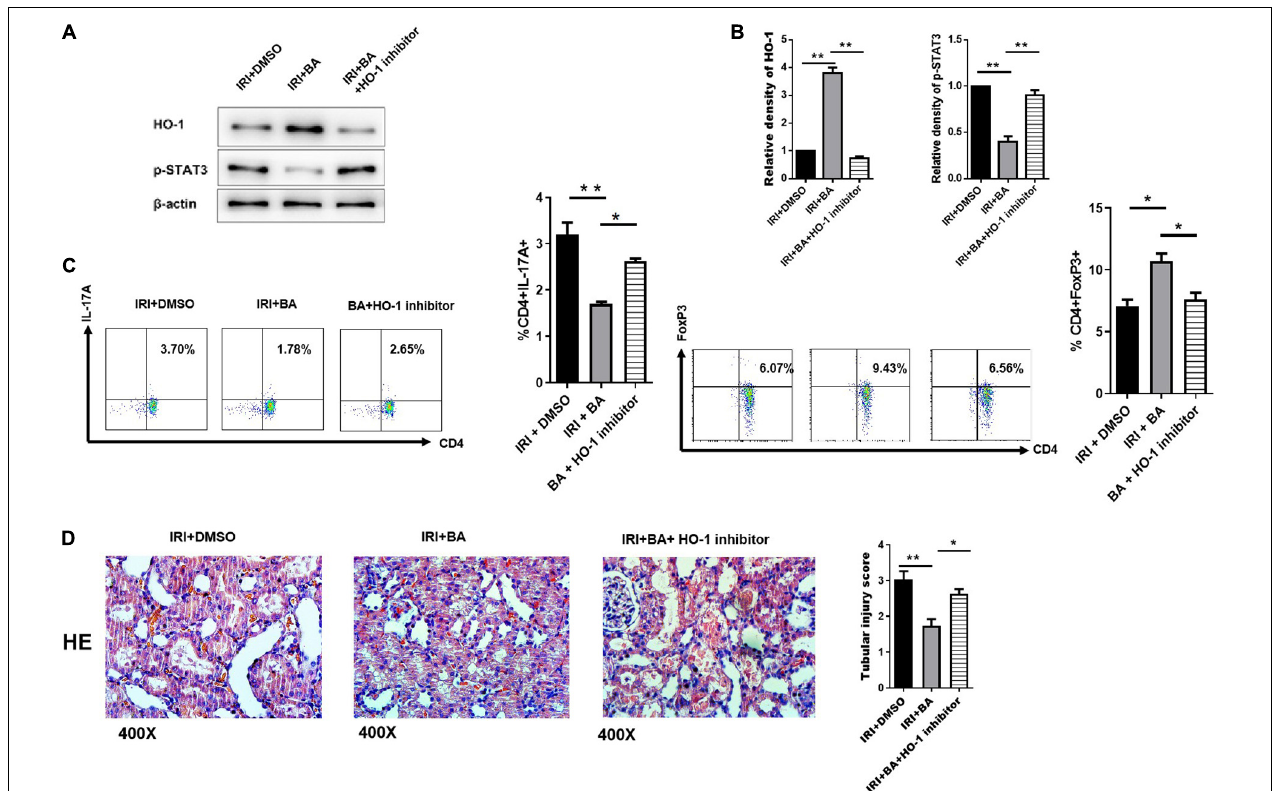
FIGURE 5 | HO-1/p-STAT3 signaling pathway was implicated in Treg/Th17 balance mediated by BA. (A,B) SnPP (the inhibitor of HO-1), significantly reduced the up-regulation of BA-related p-STAT3 expression. (C) In CD4 + T cells under Treg/TH17 polarizing conditions. BA/Snpp co-treatment reversed the immunological balance of Treg/Th17 cells by BA only. (D) HE staining show that SnPP treatment significantly, but not wholly, reversed the regulating effect of BA. Sample size = 3 in each group. Data were presented as mean ± standard deviation. N.S. P > 0.05, * P < 0.05, ** P <